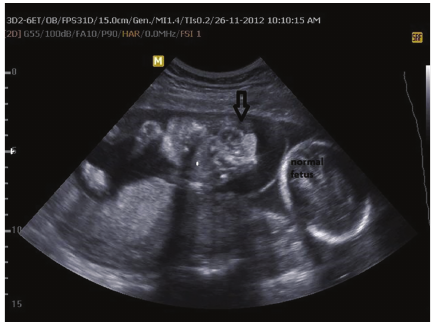
Figure 1: Ultrasonographic view of twins at 23 weeks of gestational age; arrow indicated heart protruding out of the sternal defect.